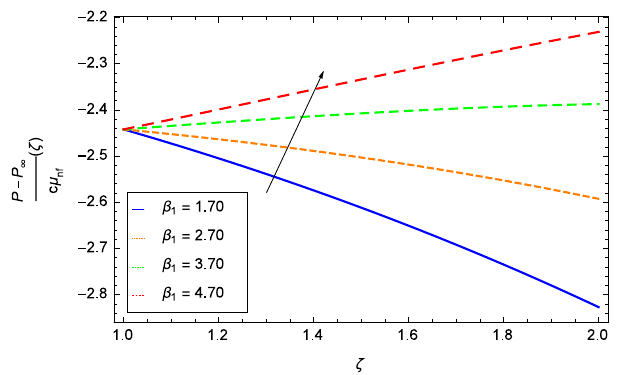
Figure 13. Non-dimensional Pressure P − P ∞ Pr = 6.80 and various values of β 1 (CuO-H 2 O).